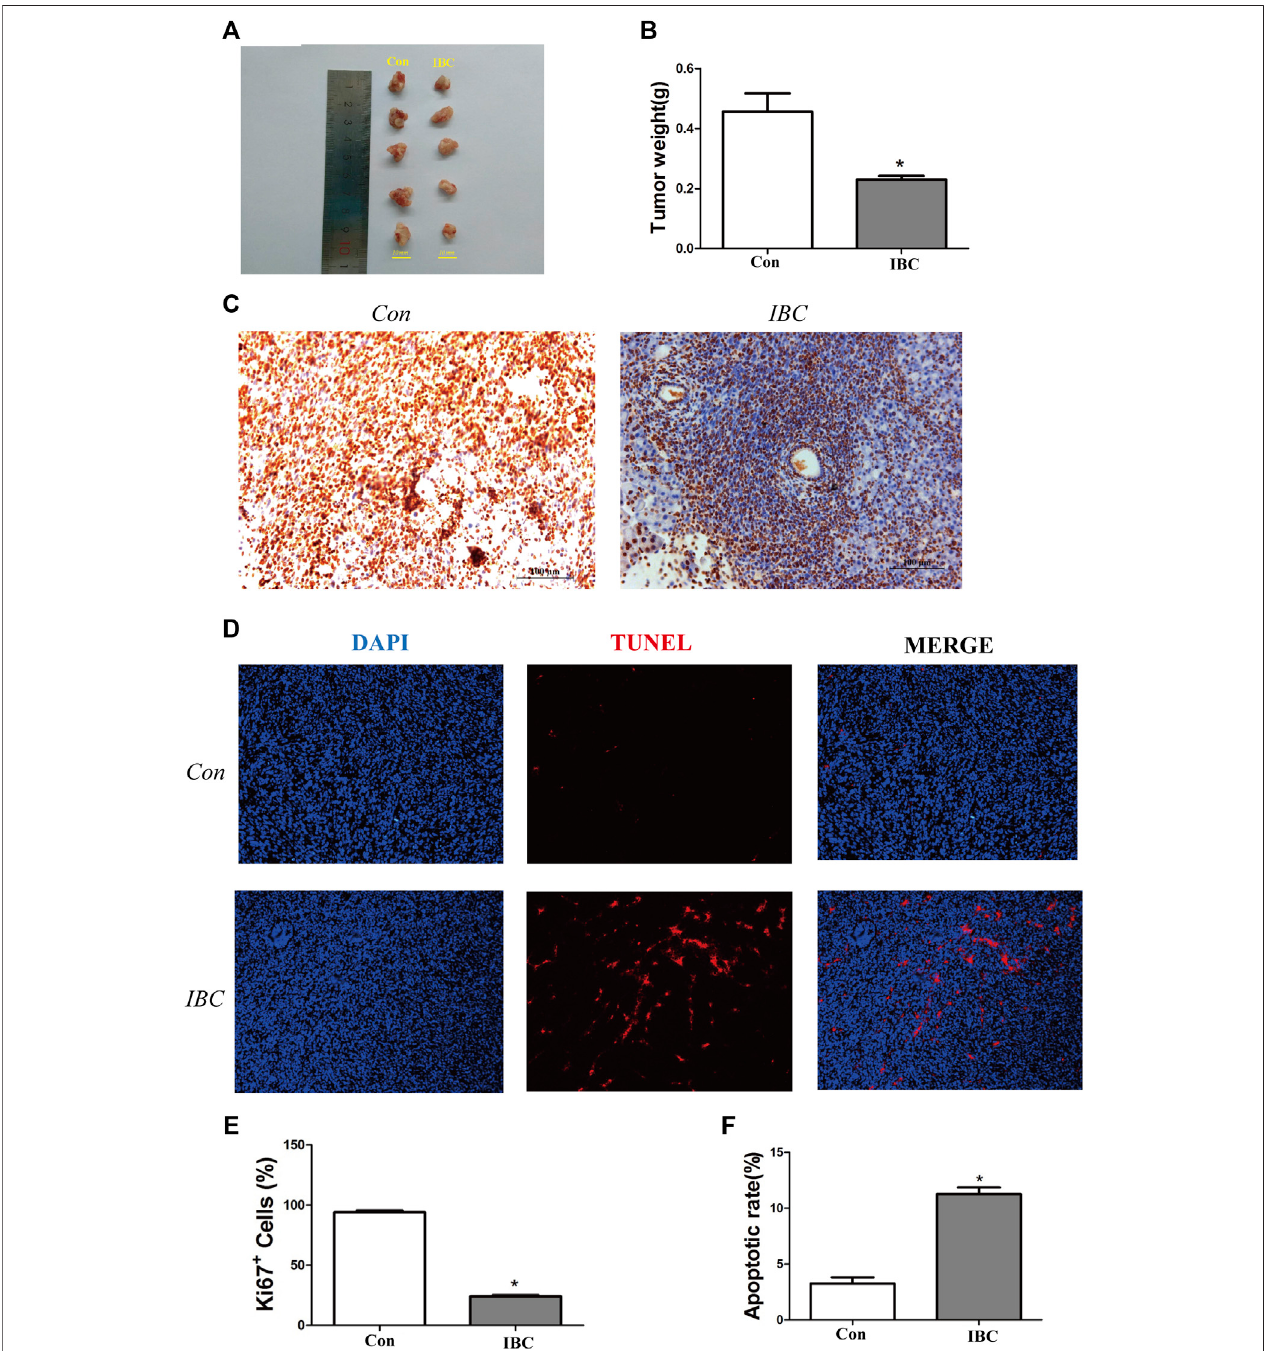
FIGURE 8 | IBC slowed the growth of pancreatic cancer in vivo . (A,B) Tumor tissues were isolated from the orthotopic models ( N = 5). The therapeutic mice with orthotopic pancreatic tumors were treated with IBC (20 mg/kg) for 10 days. The columns represent the mean ± SEM. Student ’ s t -test was applied to analyze the data; * p < 0.05 versus thecontrol. (C) Expressionof Ki67in tissues wasvalued through immunohistochemistry (scale:100 μ m). (D) TUNEL stainingshowed the proportion of apoptotic cells in tissues (scale: 100 μ m). (E) Quantitative analysis of the Ki67 + cells in tumor tissues, * p < 0.05 versus the control. (F) Quantitative analysis of the apoptosis rate in tumor tissues, * p < 0.05 versus the control.